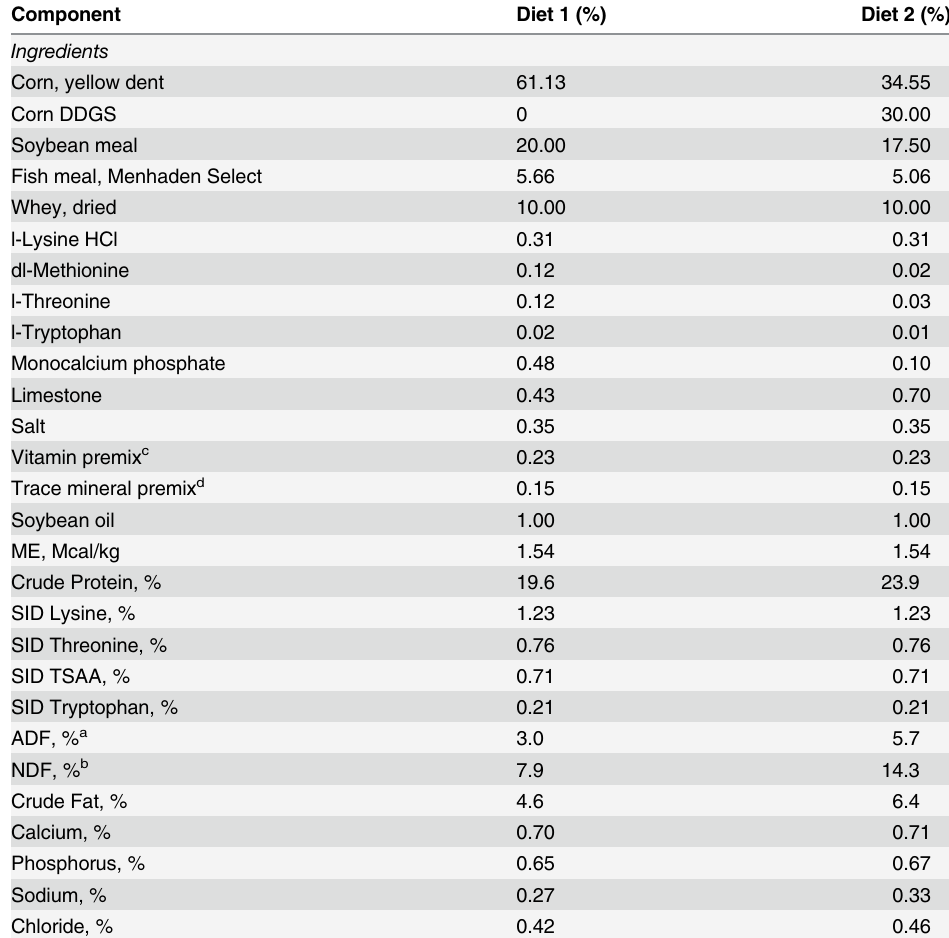
Table 1. Ingredient and nutrient composition of experimental